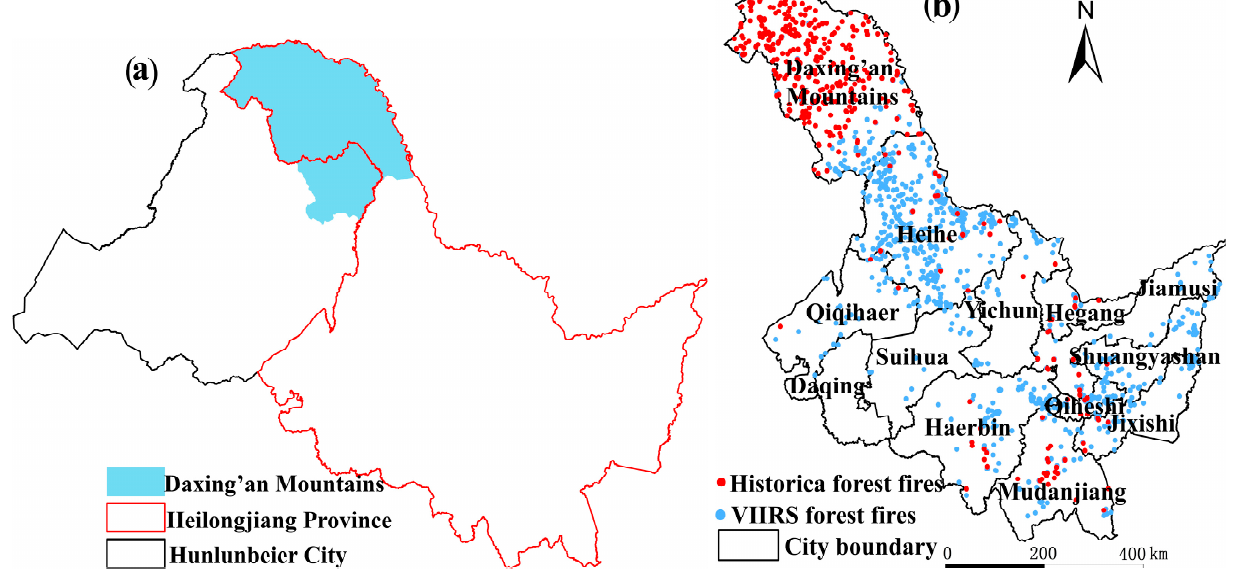
Figure 1. Spatial distribution of historically recorded and VIIRS-detected forest fires in the jurisdiction of Heilongjiang Province, 2013–2020. In map ( a ), the red line represents the administrative boundary of Heilongjiang Province, the black line represents the administrative boundary of Hulunbeier City, and the blue shaded area denotes the Daxing’an Mountains. In map ( b ), the study area of this paper is displayed, with red dots indicating historically recorded forest fires and blue dots representing VIIRS-detected forest fires. By combining maps ( a , b ), it is evident that the study area of this paper covers two provinces.